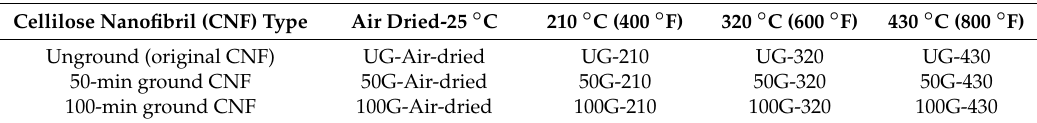
Table 1. Different sample combinations and